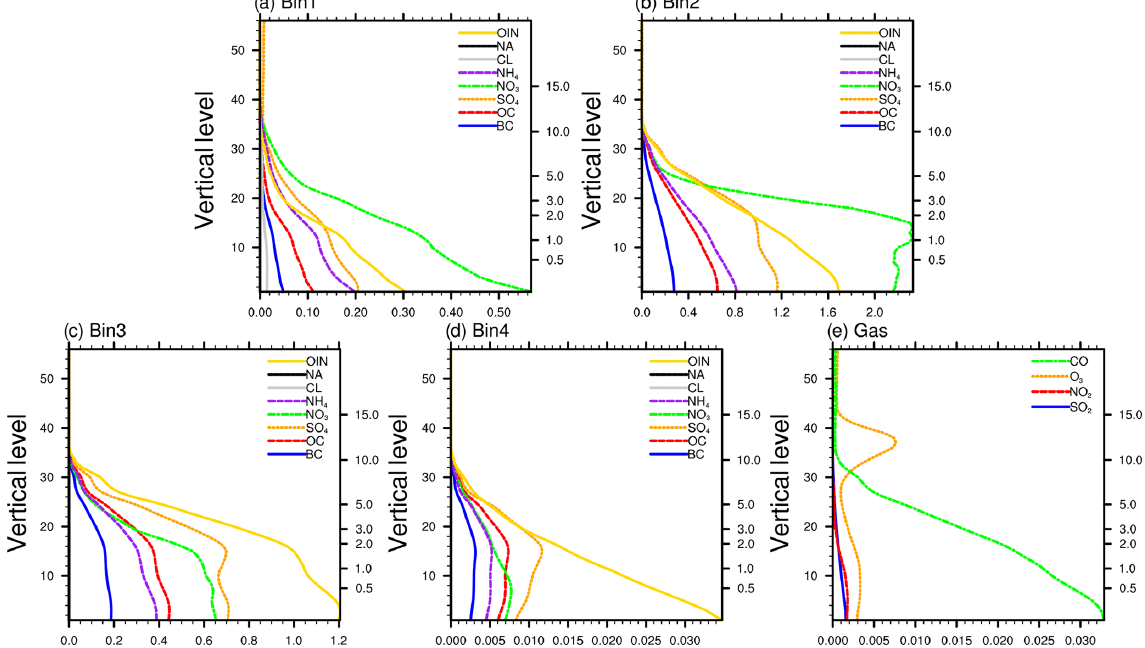
Figure 2. Background error standard deviations of aerosol species of the (a) first size bin, (b) second size bin, (c) third size bin, (d) fourth size bin, and (e) gas pollutants. The units for the x axis are micrograms per cubic meter for (a–d) and parts per million for (e) . The left y axis denotes the model level, and the right y axis denotes the vertical height (units: